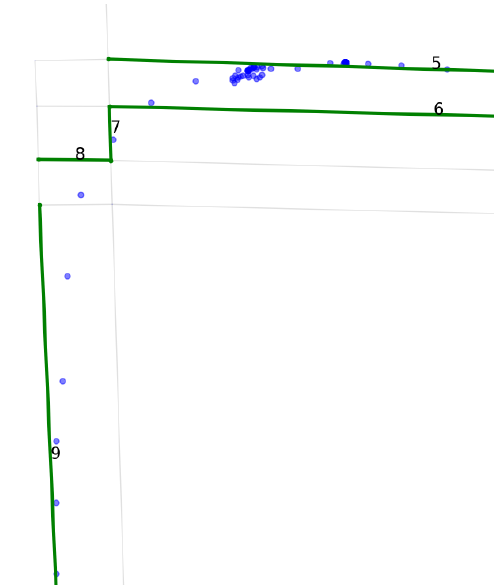
Figure 7. Multiple different types of error observed in Dataset